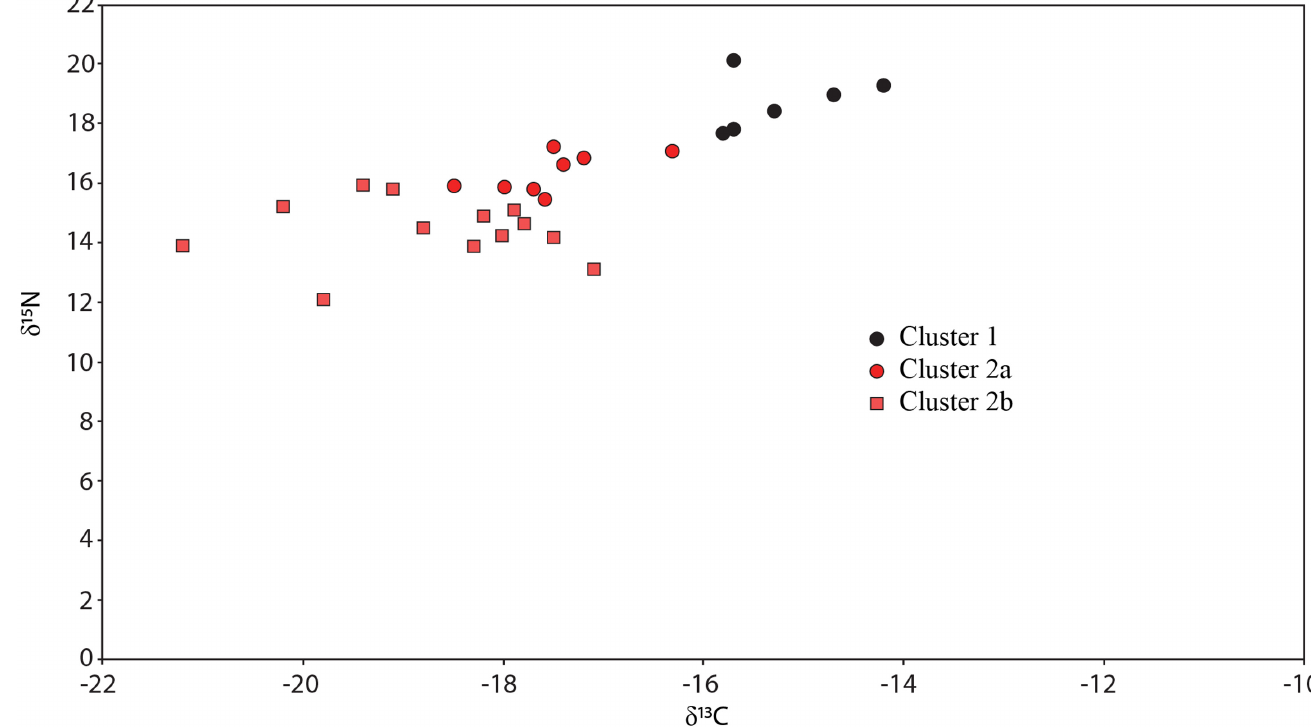
Fig 3. Scatter plot of the Clusters determined by Ward's Linkage hierarchical